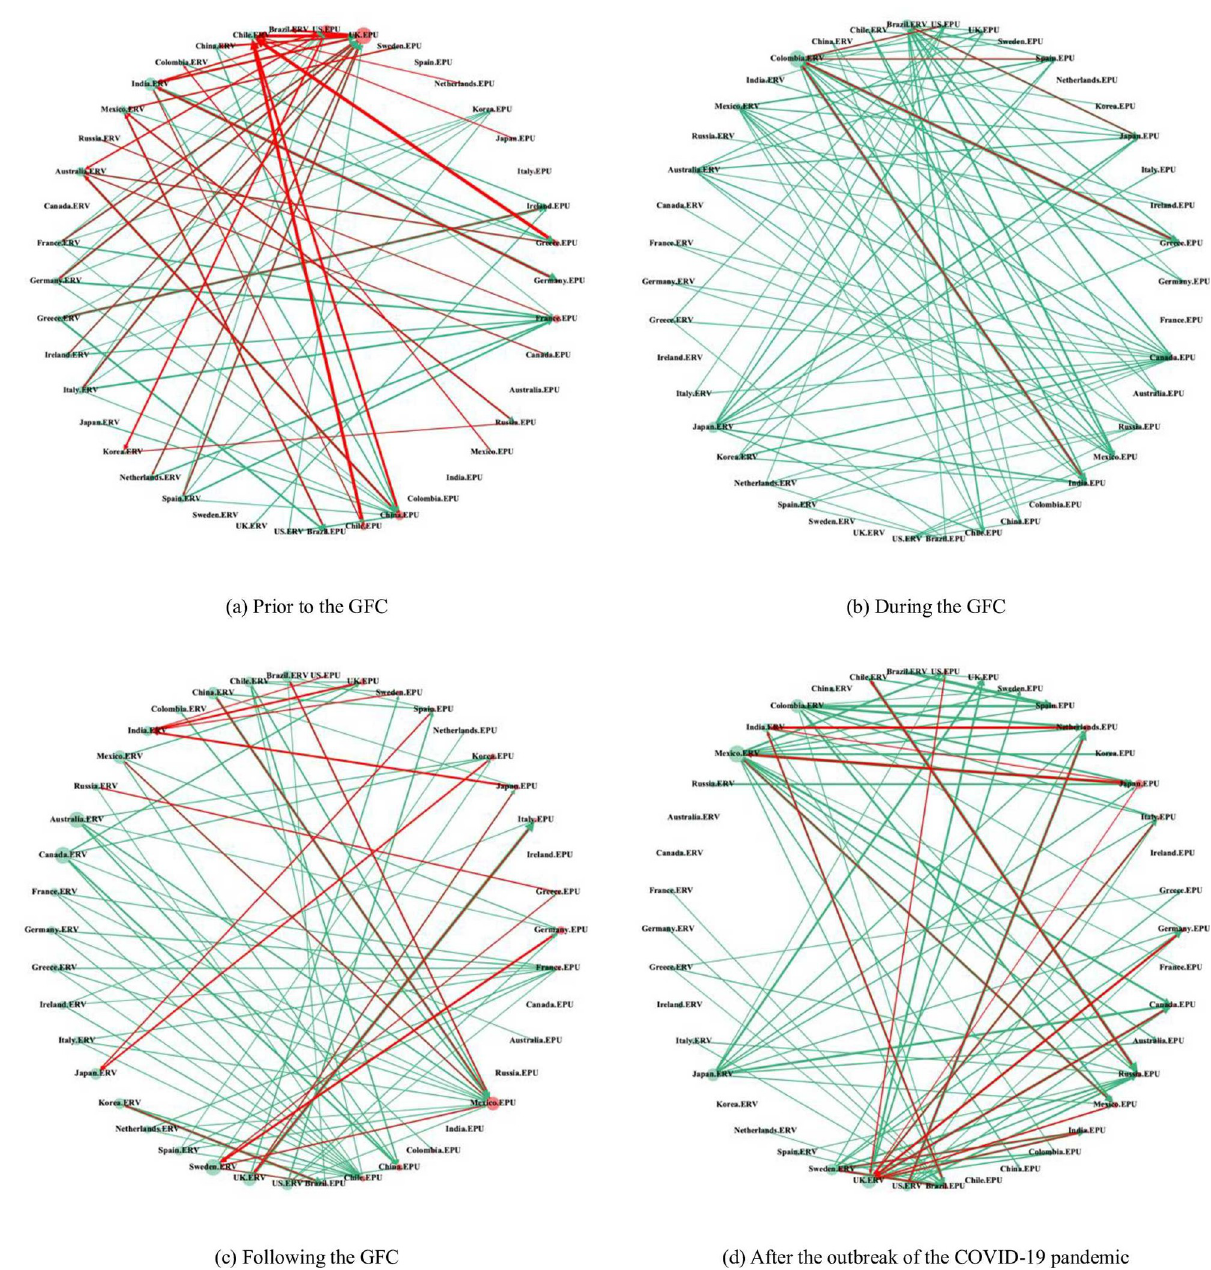
Fig 3. Cross-market spillover network between EPU and ERV in different periods. (i) X.EPU represents the EPU of country X, and X.ERV represents the exchange rate volatility of country X. (ii) The figure shows the top 10% quantile of the cross-market spillover relationships between EPU and ERV, where the green line represents the spillover of ERV on EPU, and the red line represents the spillover of EPU on ERV. (iii) The arrow represents the direction of the spillover; the thickness of the line represents the intensity of the spillover. (iv) (a), (b), (c) and (d) correspond